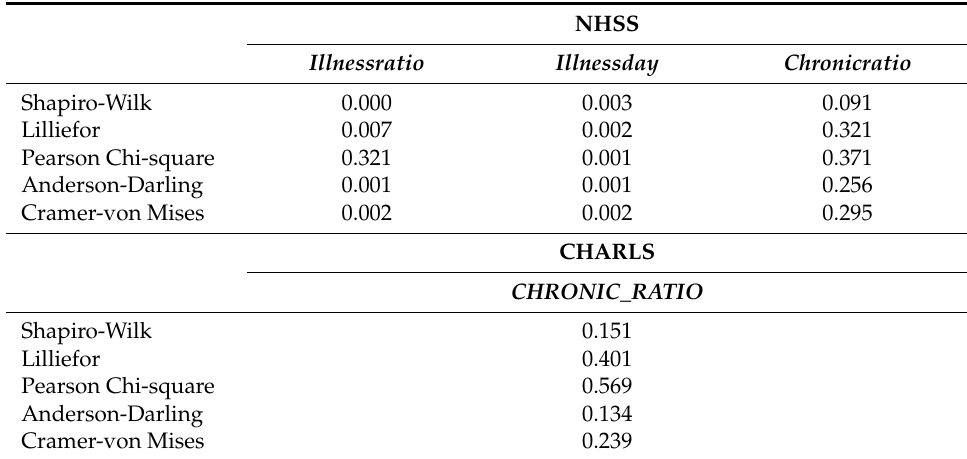
Table A9. Normality tests on regression